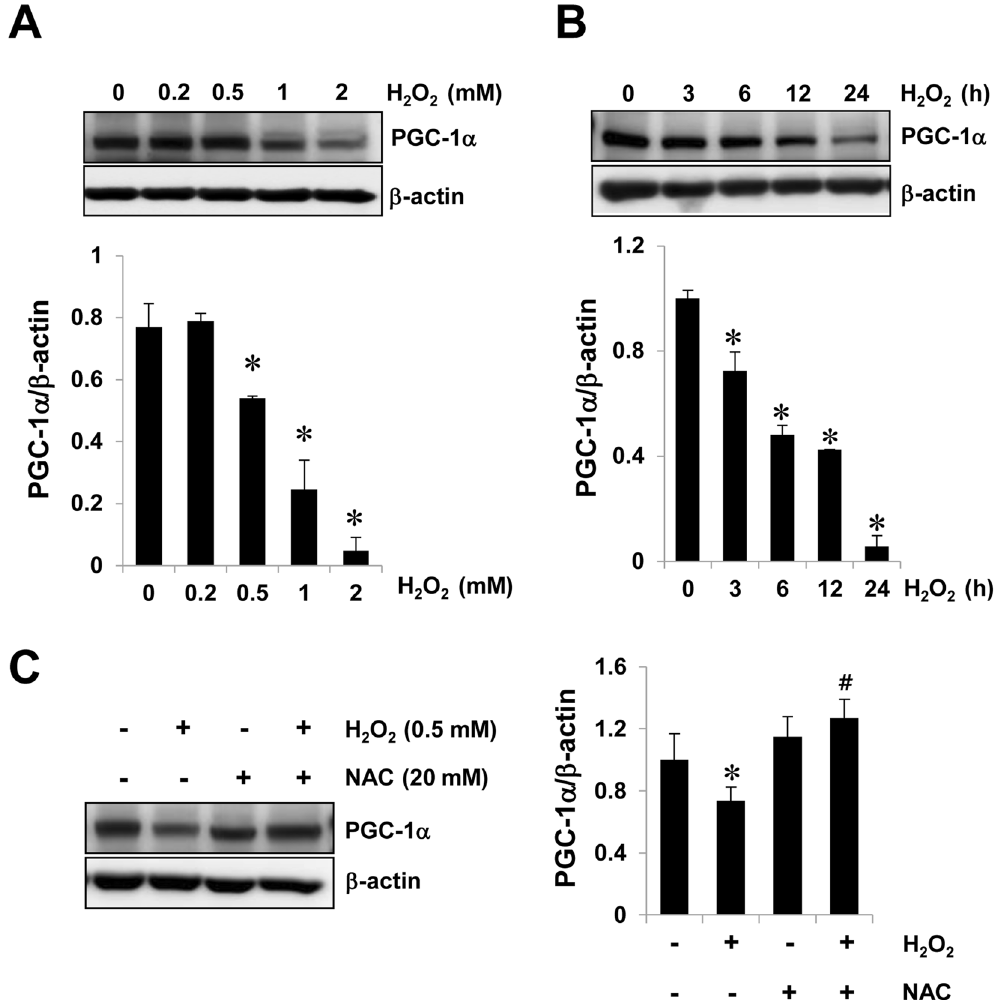
Figure 2. Downregulation of PGC-1 α in H 2 O 2 -treated HK-2 cells. To mimic I/R-induced oxidative stress in an in vitro system, we treated with H 2 O 2 in HK-2 cells. ( A ) Dose-dependent PGC-1 α expression. HK-2 cells were treated with an indicated H 2 O 2 concentration (0, 0.2, 0.5, 1, and 2) for 6 h. ( B ) Time-dependent PGC-1 α expression. HK-2 cells were treated with 0.5 mM H 2 O 2 for an indicated time (0, 3, 6, 12, and 24 h). ( C ) To assess the effect ROS in H 2 O 2 induced PGC-1 α downregulation, cells were incubated for 6 h with 0.5 mM H 2 O 2 in the presence or absence of 20 mM NAC. The bar graph shows the relative protein expression of PGC-1 α measured by densitometry. β -actin levels were analyzed as internal controls. Full-length blots of each tested protein are reported in Supplementary Figure S2. Error bars denote the mean ± S.D. of triplicate samples. * p < 0.05 H 2 O 2 -treated vs. H 2 O 2 -untreated. # p < 0.05 H 2 O 2 -treated in the presence of NAC vs. H 2 O 2 -treated in the absence of